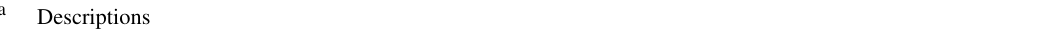
Table 3. Experiments T1–T3.